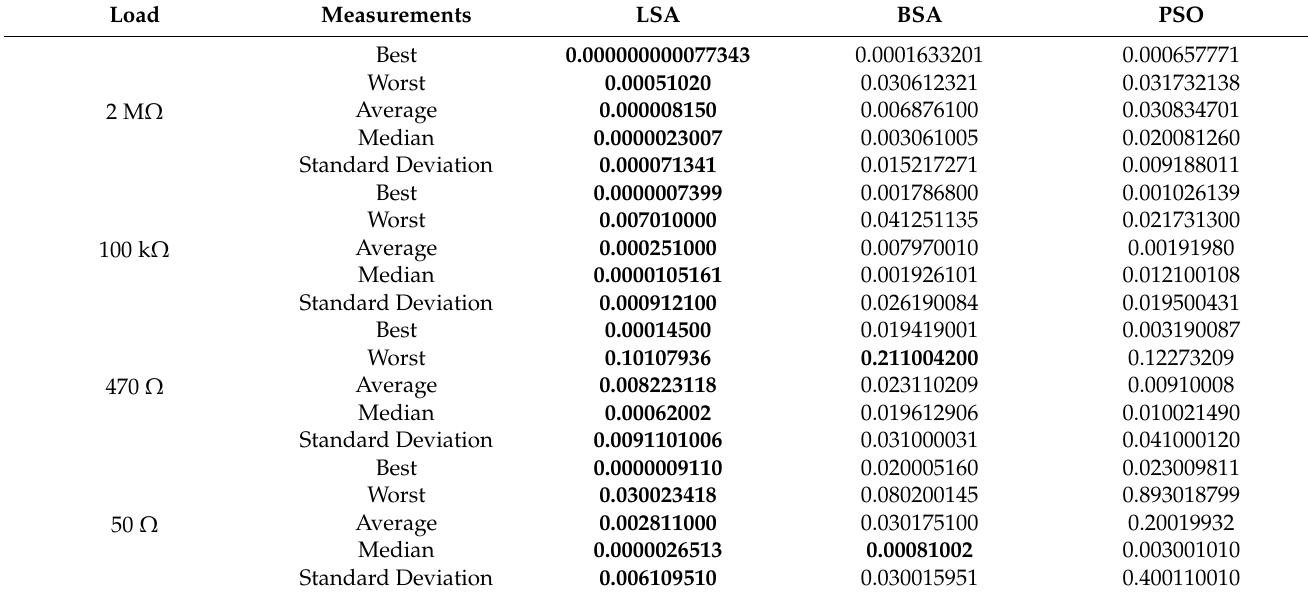
Table 2. Global optimum outcomes for every fitness functions in mean absolute error (MAE). Load Measurements LSA BSA